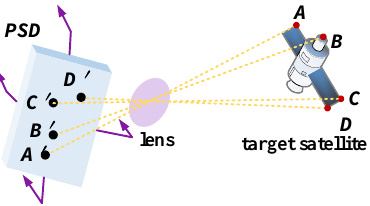
Figure 20. The VisNav sensor’s relative navigation schematic.